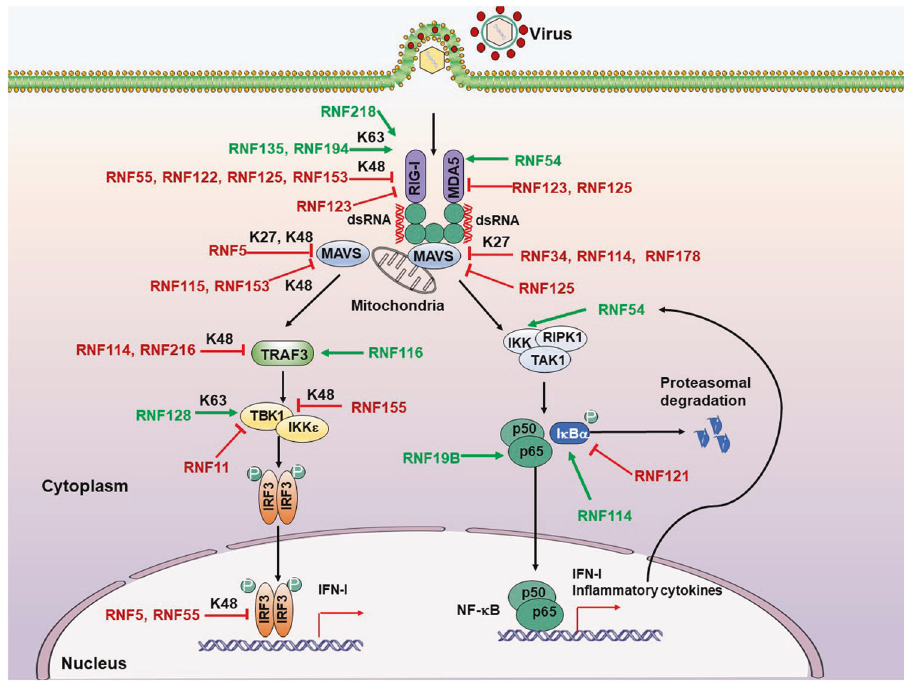
Fig. 3 RNF proteins modulate the RLR signaling pathway. Following the recognition of distinct dsRNA features by RIG-I and MDA5, their CARDs recruit and activate the downstream adaptor protein MAVS to trigger IRF3 and NF- κ B activation, resulting in the production of IFN-I and in fl ammatory cytokines. RNF proteins emerged as key regulators via positively (green arrows) or negatively (red T-shaped solid line) modulating the RLR signaling pathway. P,